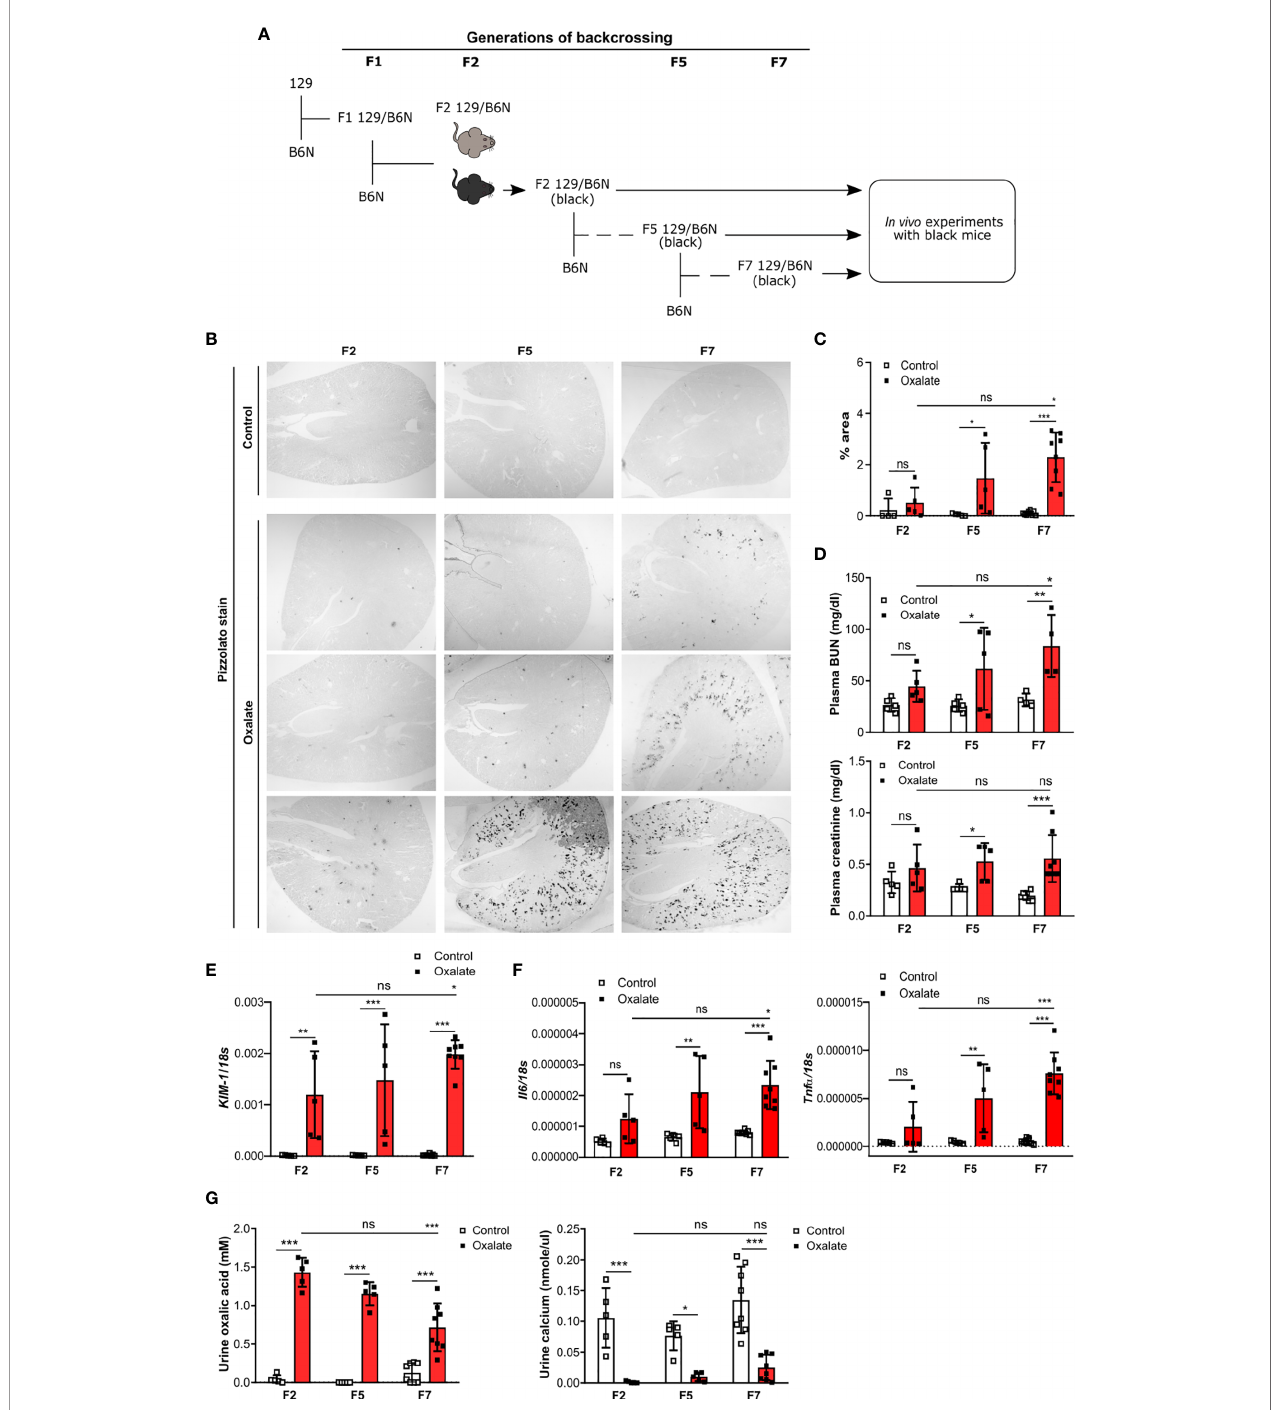
FIGURE 4 | Backcrossing of 129 mice on a B6N background drives CaOx crystal-induced nephropathy. (A) Schematic diagram indicates the regime of generating 129/B6N mice by breeding 129 with B6N mice for up to 7 generations (F2, F5 and F7). Afterward, 129/B6N F2, F5 and F7 mice were either fed a control diet or an oxalate-rich diet for 14 days. (B, C) Pizzolato staining to identify CaOx crystal deposits in kidney sections (B) and the quanti fi cation (C) . Original magni fi cation ×25. (D) Plasma BUN and creatinine levels were measured using colorimetric assays. (E, F) Intrarenal mRNA expression levels of KIM-1 (E) as well as Il6 and Tnf a (F) determined by RT-PCR. (G) Urinary concentrations of oxalic acid and calcium. Data are mean ± SD from 5 to 8 mice per group. *p < 0.05; **p < 0.01; ***p < 0.001; ns, not signi fi